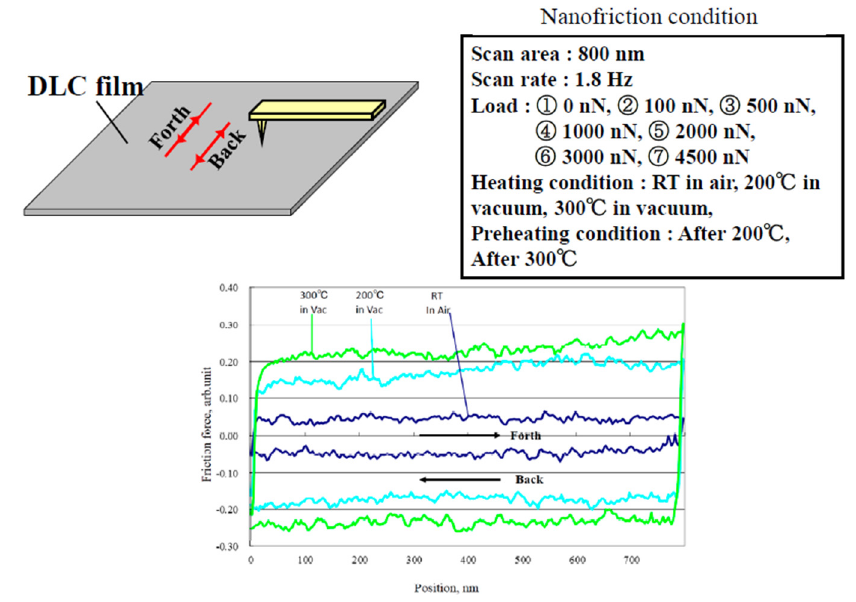
Figure 2. Nano - friction test. Figure 2. Nano-friction